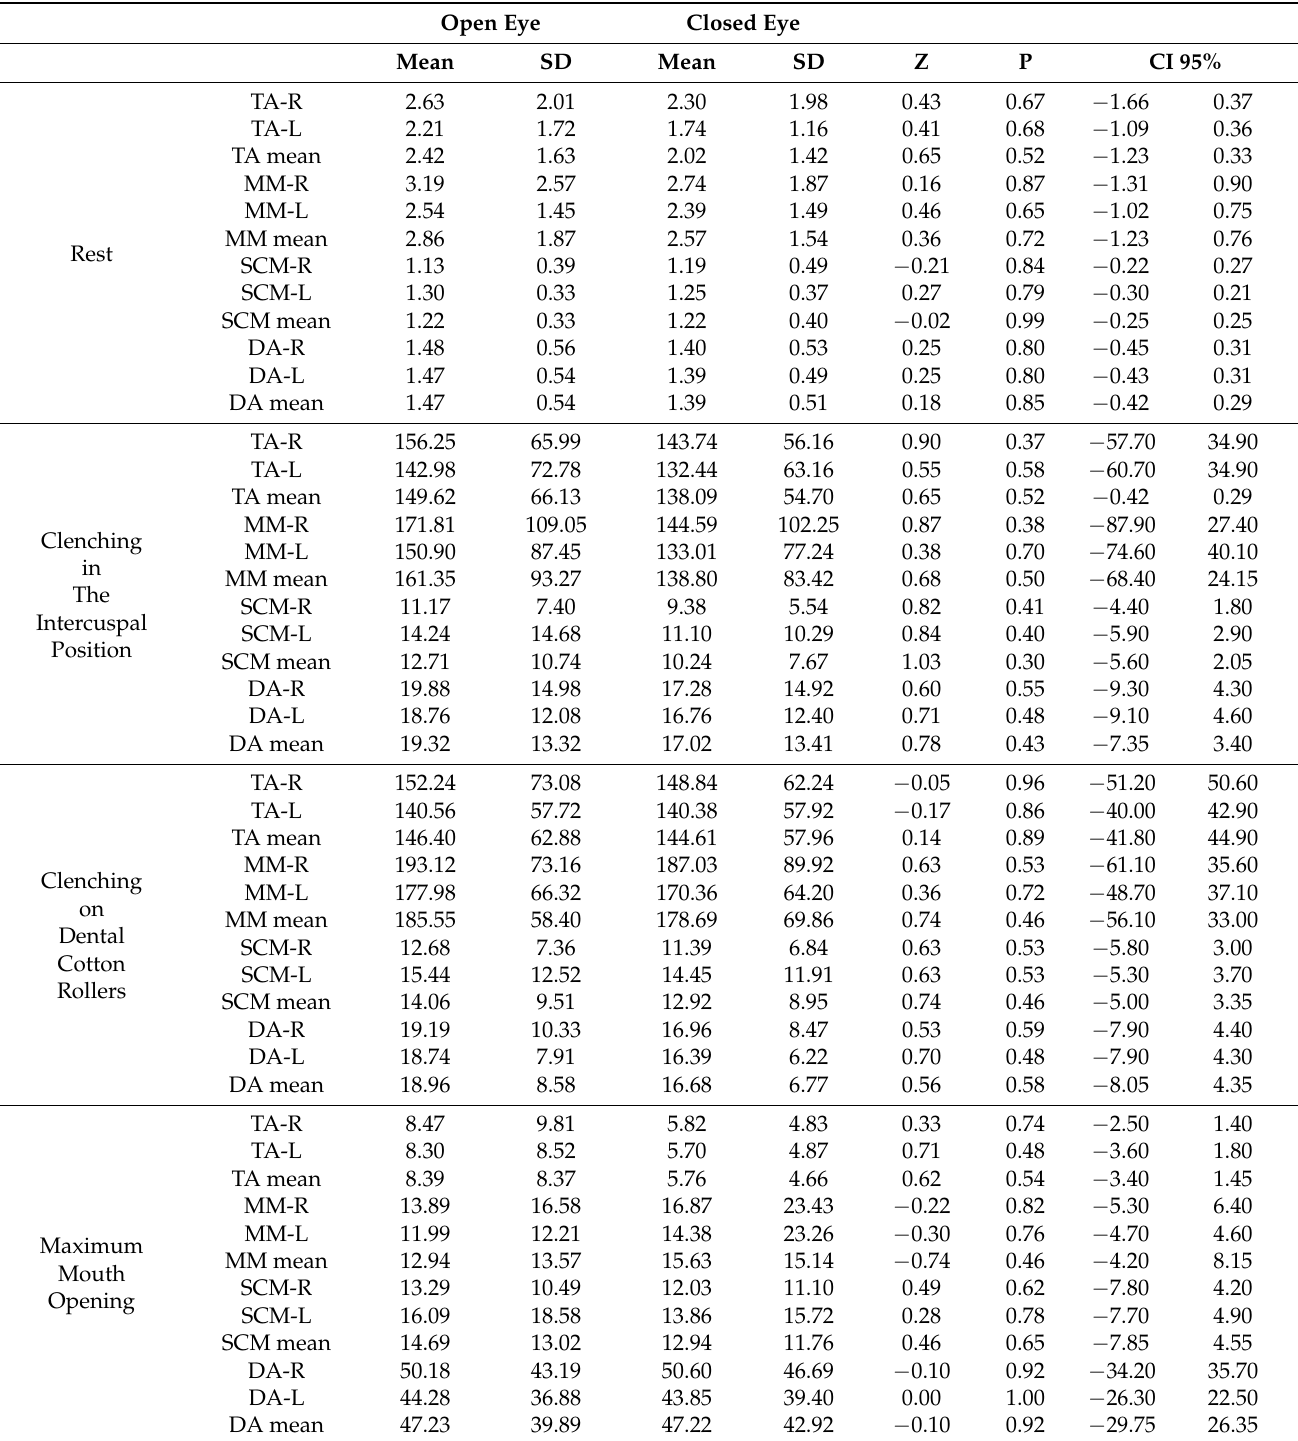
Table 4. Results of comparison of bioelectrical activity of selected muscles of the masticatory and cervical spine muscles in